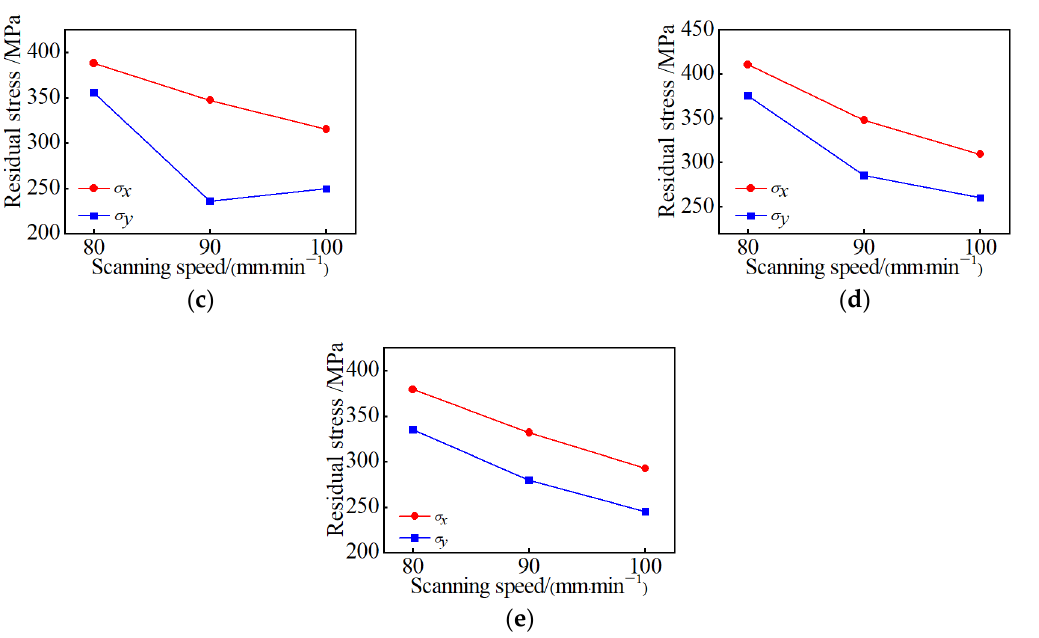
Figure 13. Residual stress at different scanning speeds: ( a ) Test point A; ( b ) Test point B; ( c ) Test point C; ( d ) Test point D; ( e ) Test point E.